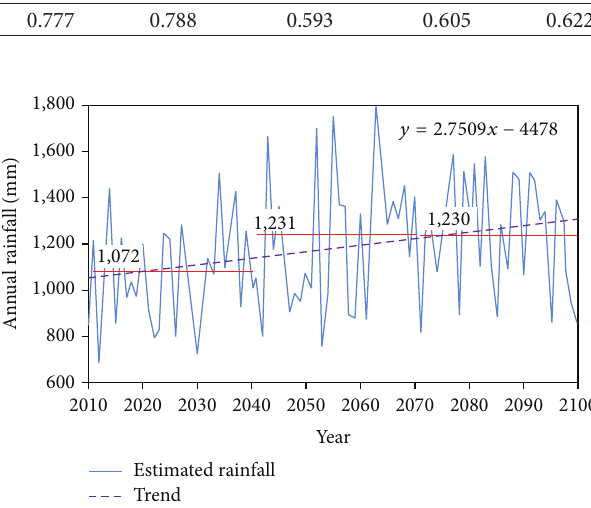
Figure 10: Forecast of future annual rainfall levels using climate change scenario